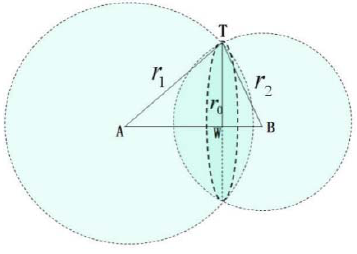
Figure 4. Schematic of circular constraint diagram.